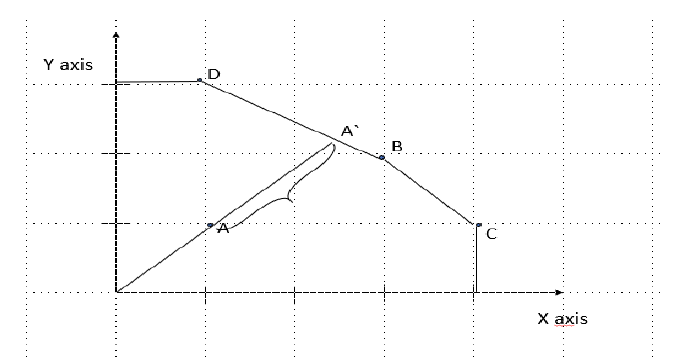
Fig. 1. DEA efficiency frontier (for “the biggest” desired values)